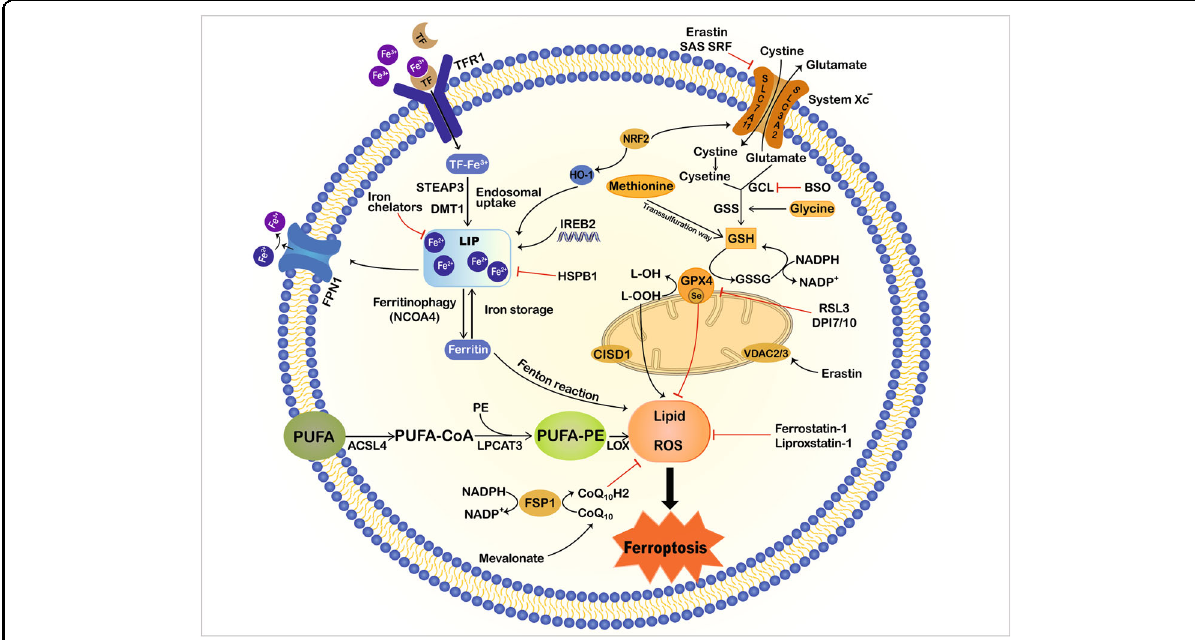
Fig. 1 Mechanisms of ferroptosis. Ferroptosis is characterised by iron accumulation, excessive ROS production and overwhelming lipid peroxidation. Three main metabolic pathways, amino-acid/GSH, lipid, and iron pathways, participate in the initiation and execution of ferroptosis. Moreover, there are additional signalling pathways and regulators controlling ferroptosis sensitivity. This illustration shows the process of ferroptosis, summarising the key molecules and targets that regulate iron and lipid peroxidation. ACSL4 acyl-CoA synthetase long-chain family member 4, BSO buthionine sulphoximine, CISD1 CDGSH iron sulphur domain 1, DMT1 divalent metal transporter 1, FSP1 ferroptosis suppressor protein 1, FPN1 ferroportin 1, GPX4 glutathione peroxidase 4, GSH glutathione, GSSG oxidized glutathione, GSS glutathione synthetase, GCL glutamate-cysteine ligase, HO-1 haem oxygenase 1, HSPB1 heat shock protein beta-1, IREB2 iron response element-binding protein 2, LOX lipoxygenase, LPCAT3 lysophosphatidylcholine acyltransferase 3, NCOA4 nuclear receptor coactivator 4, NRF2 nuclear factor E2-related factor 2, PUFA polyunsaturated fatty acid, PE phosphatidylethanolamine, ROS